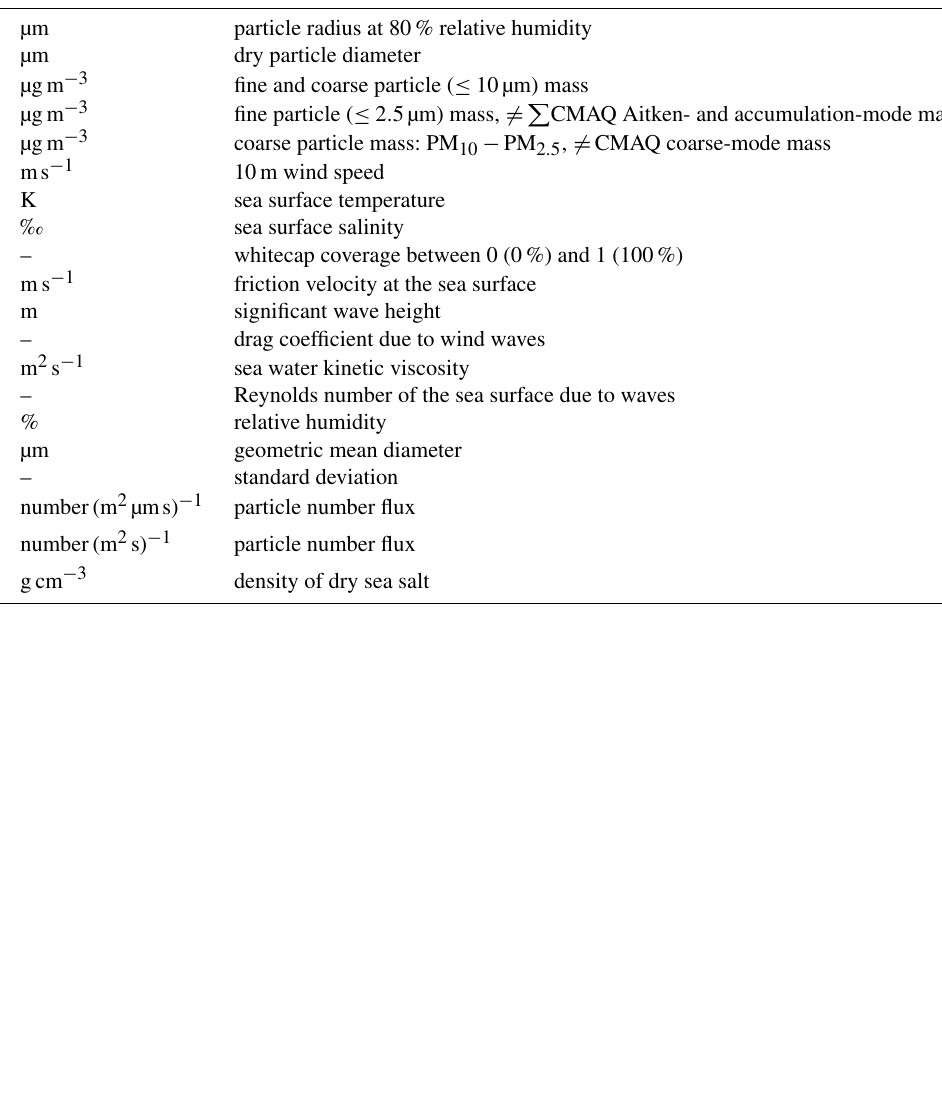
Table A1. Parameters, their units and their meaning.